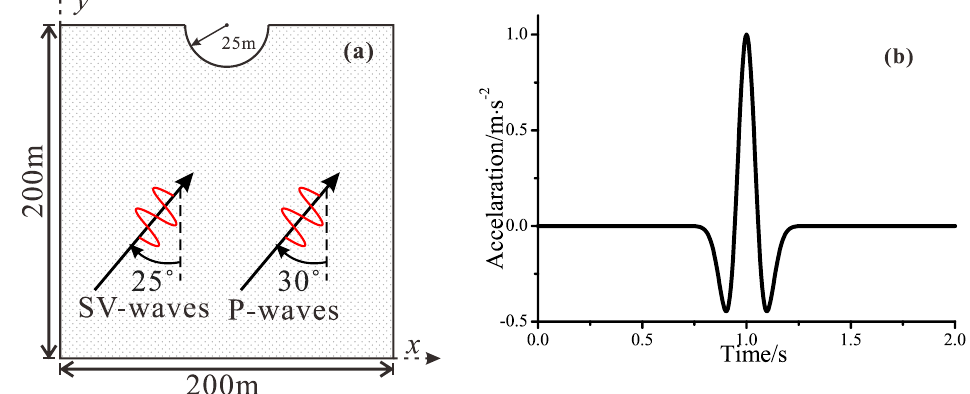
Figure 11. Numerical model and input waves of test example 2: ( a ) finite element model and ( b ) acceleration time-history of incident waves.